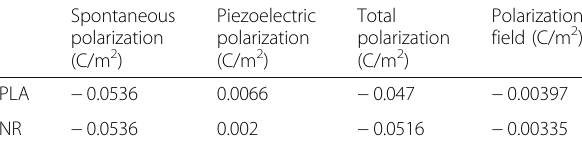
Table 3 Spontaneous polarization, piezoelectric polarization, total polarization, and polarization field in the quantum wells Spontaneous